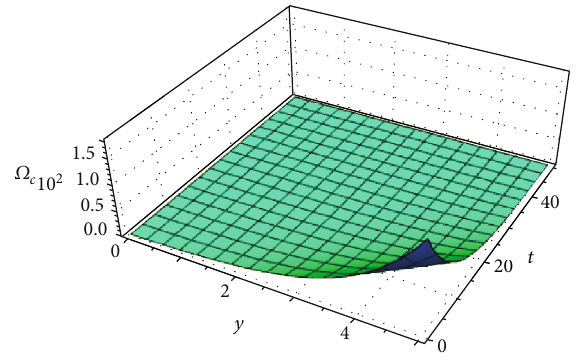
Figure 12: The gyrofrequency Ω